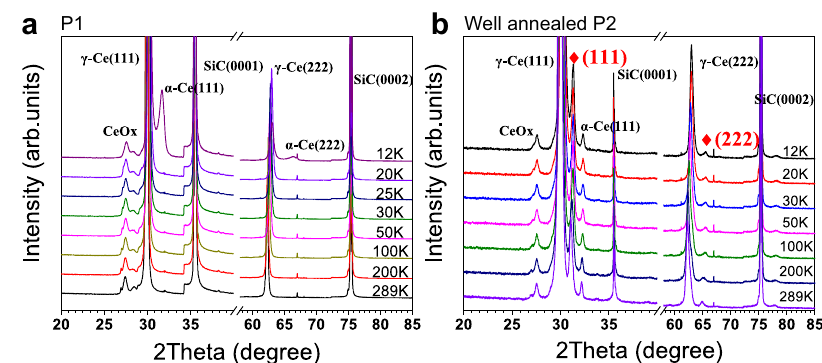
Fig. 5 Temperature-dependent XRD measurements. Ex situ temperature-dependent XRD results for P1 ( a ) and P2 ( b ). All peaks are labeled individually. The red stars in b highlight the diffraction peaks at ~31 ∘ and ~65 ∘ , corresponding to the metastable surface phase. The peak at ~28 ∘ corresponds to Ce oxides due to (inevitable) partial oxidation. The tiny peak at ~33 ∘ in b implies possibly a very small mixture of the α -phase (see Supplementary Fig. 4).